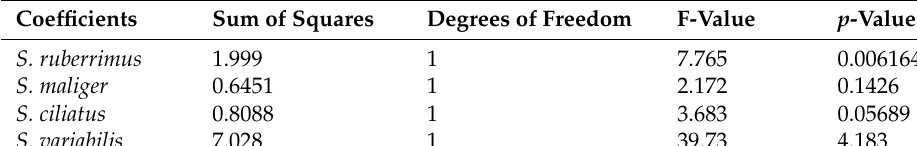
Figure 6. Mean shifts in δ 13 C and 95% confidence intervals across time for four rockfish species in this assemblage.